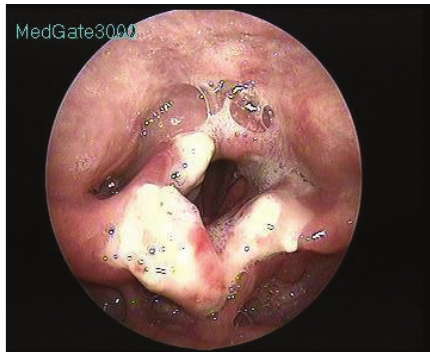
Figure 2: One week after endolaryngeal laser surgery, glottic levels were intact and white-colored granulation tissues were observed.